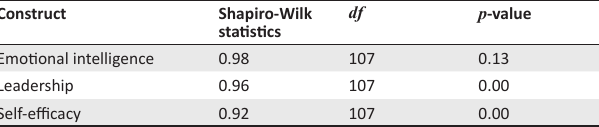
TABLE 5: Shapiro-Wilk’s test of normality for constructs.